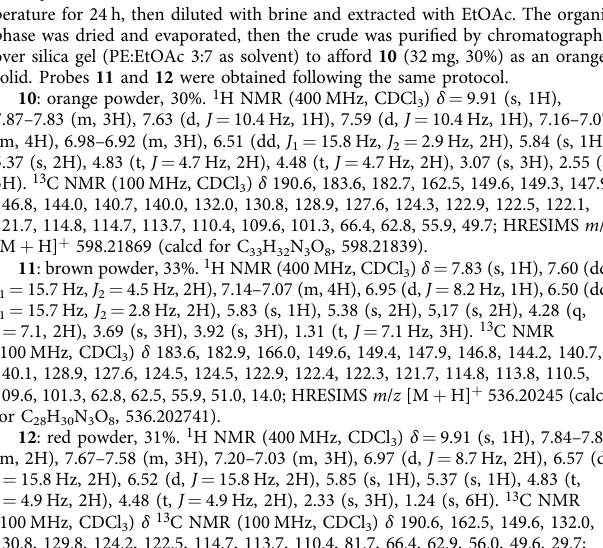
General procedure for copper catalyzed 1,3-dipolar cycloaddition: synthesis of Probe 10 as example . To a stirred solution of 6 (50 mg, 0.123mmol, 1 eq) in t - BuOH/H 2 O/CH 3 CN 2:1:1, 8 (56 mg, 0.256mmol, 2 eq) and a catalytic amount of CuSO 4 and sodium ascorbate were added. The solution was stirred at room